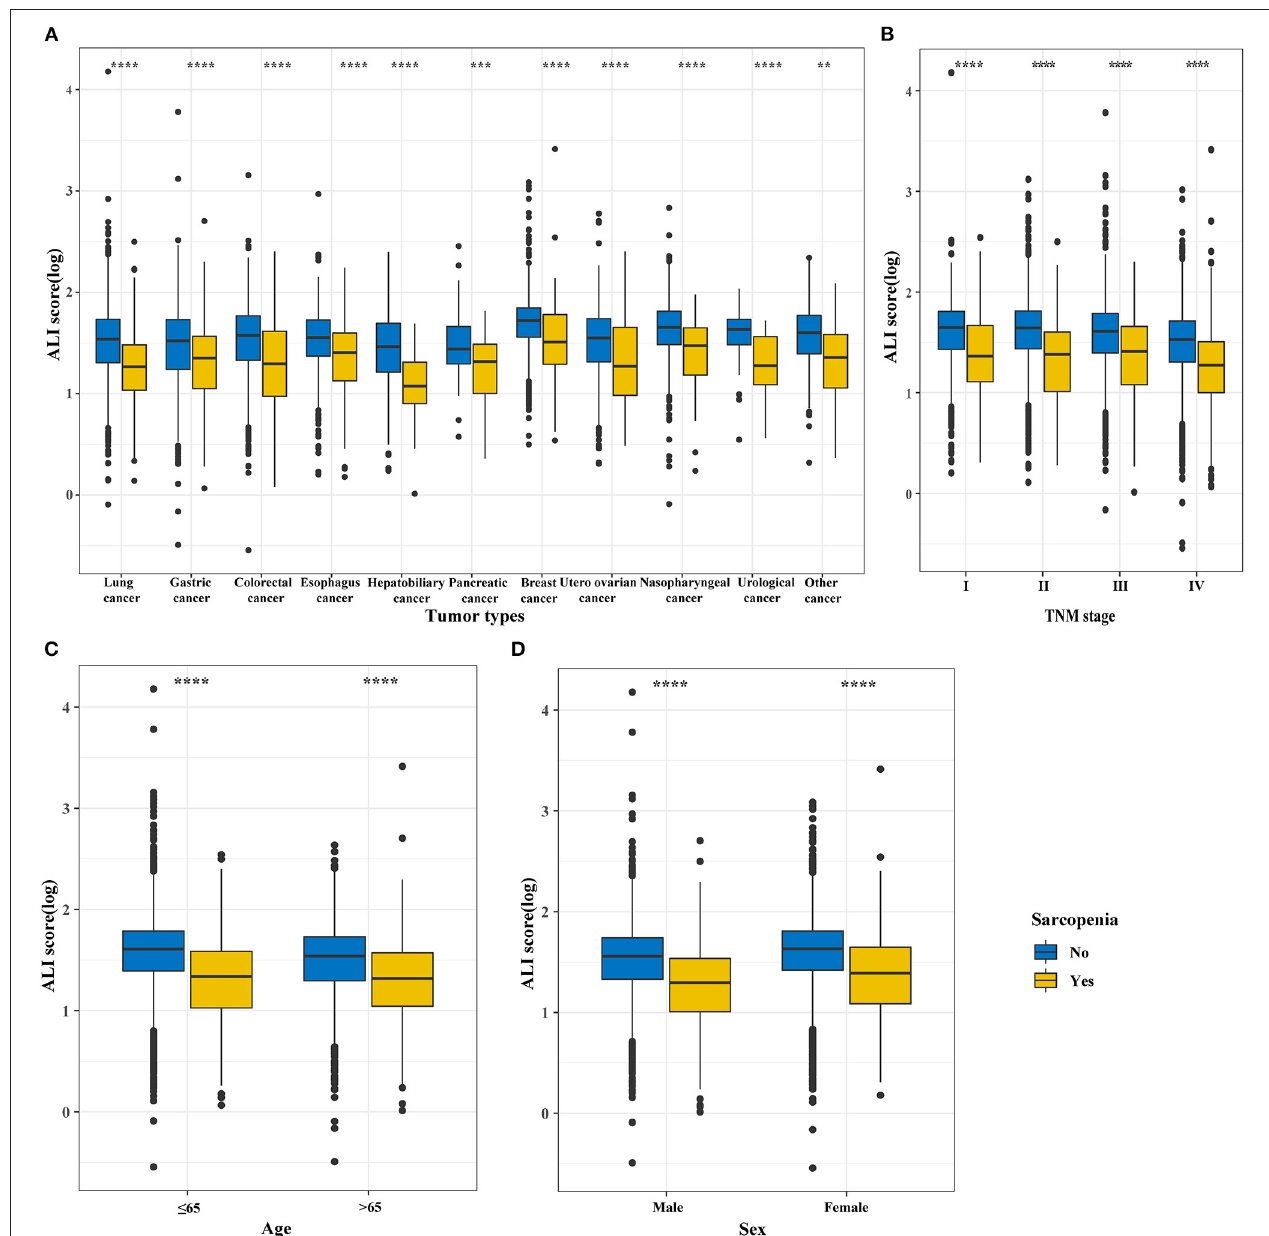
FIGURE 2 | The distribution of the ALI in different groups based on sarcopenia subgroup and non-sarcopenia subgroup divisions. (A) Tumor types; (B) TNM stages; (C) Age; (D) Sex. ALI, Advanced Lung Cancer Inflammation Index.